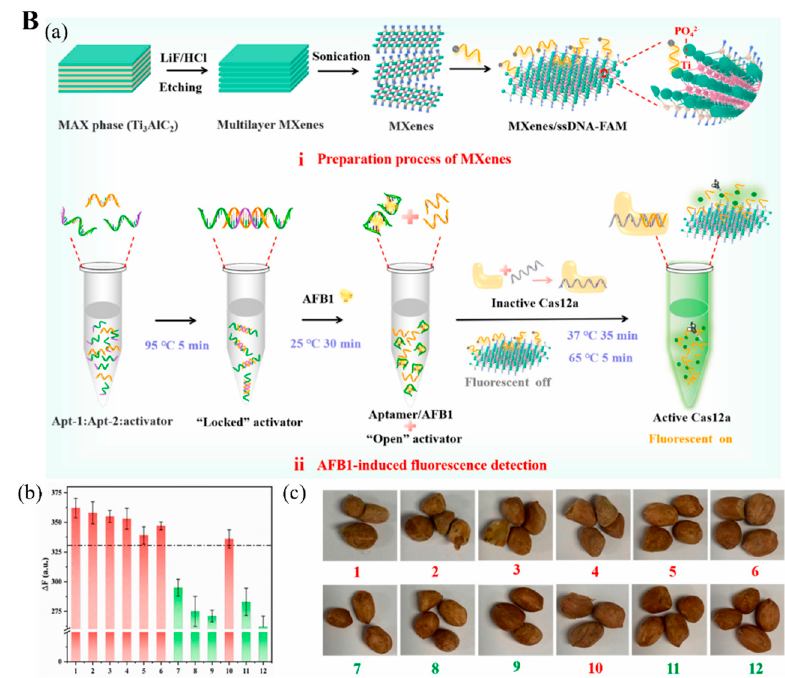
Figure 7. ( A ) ( a ) Diagram of the assembly process of electrochemical aptasensor for OTA analysis. ( b ) Voltammetric response of aptasensor in the presence of different OTA concentrations. ( c ) Rela- tionship between the electrochemical response and OTA concentration. Inset. The linear relationship between the response and OTA concentration. Reproduced with permission from Ref. [87].